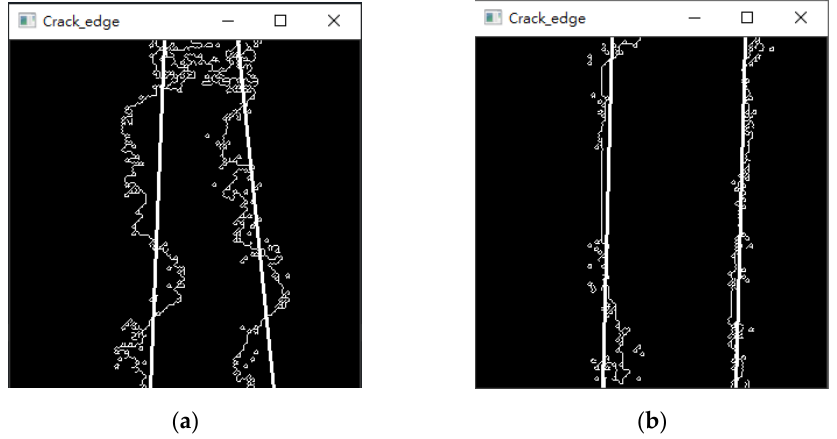
Figure 17. ( a ) Dangerous gap linear regression results. ( b ) Non-dangerous gap linear regression results.